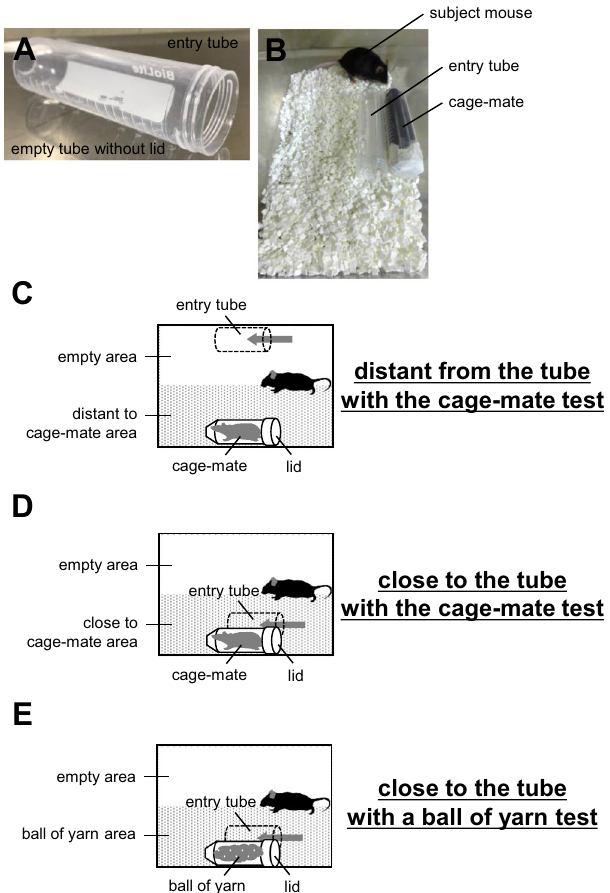
Figure 3. Schematic diagram of tube entry tests depending on the location of the tube. ( A ) A sample image of the entry tube. ( B ) A sample picture of the setup with the entry tube close to the tube containing the cage-mate in the new home cage. ( C ) Schematic diagram of the setup with the entry tube distant from the tube containing the cage-mate. ( D ) Schematic diagram of the setup with the entry tube close to the tube with the cage-mate. ( E ) Schematic diagram of the setup showing the entry tube close to the tube with a ball of